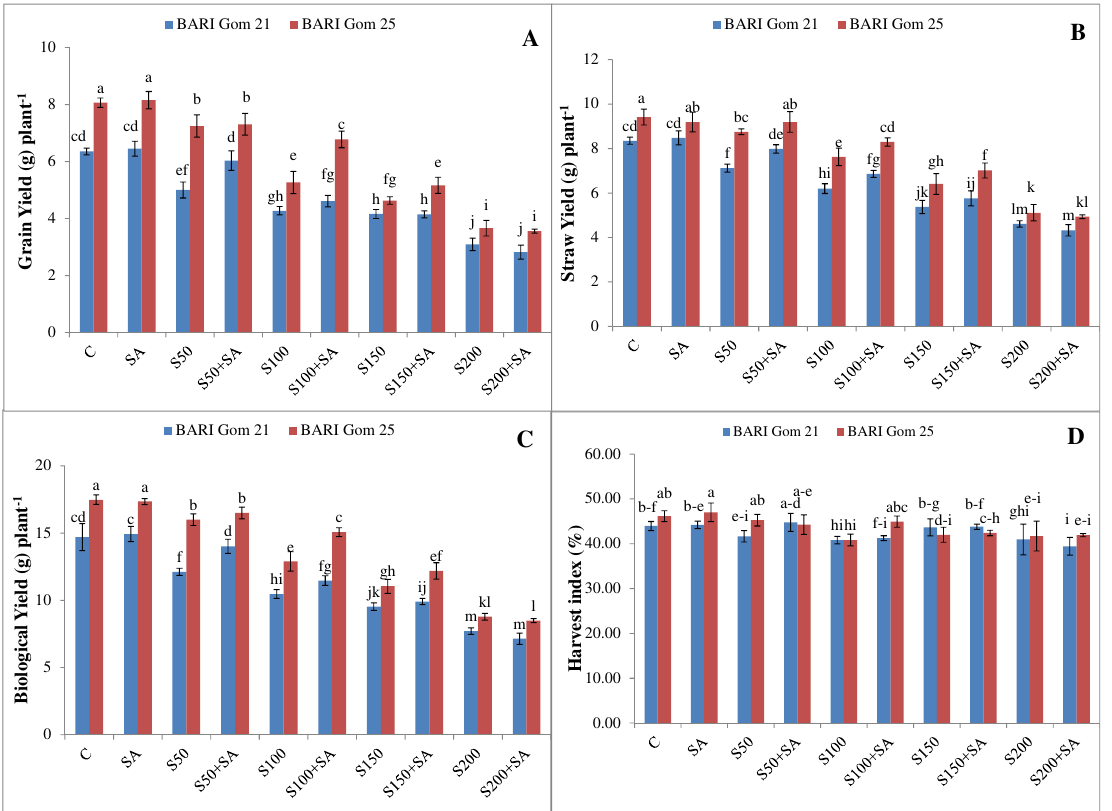
Fig. 8. ( A ) Grain yield, ( B ) straw yield, ( C ) biological yield and ( D ) harvest index in salt sensitive and salt tolerant wheat plants induced by exogenous salicylic acid under salt stress. S50, S100, S150 and S200 indicate 50 mM, 100 mM, 150 mM and 200 mM NaCl, respectively. SA indicates 1 mM salicylic acid spray, respectively. Mean (±SD) was calculated from three replicates for each treatment. Values in a column with different letters are significantly different at p ≤ 0.05 applying LSD